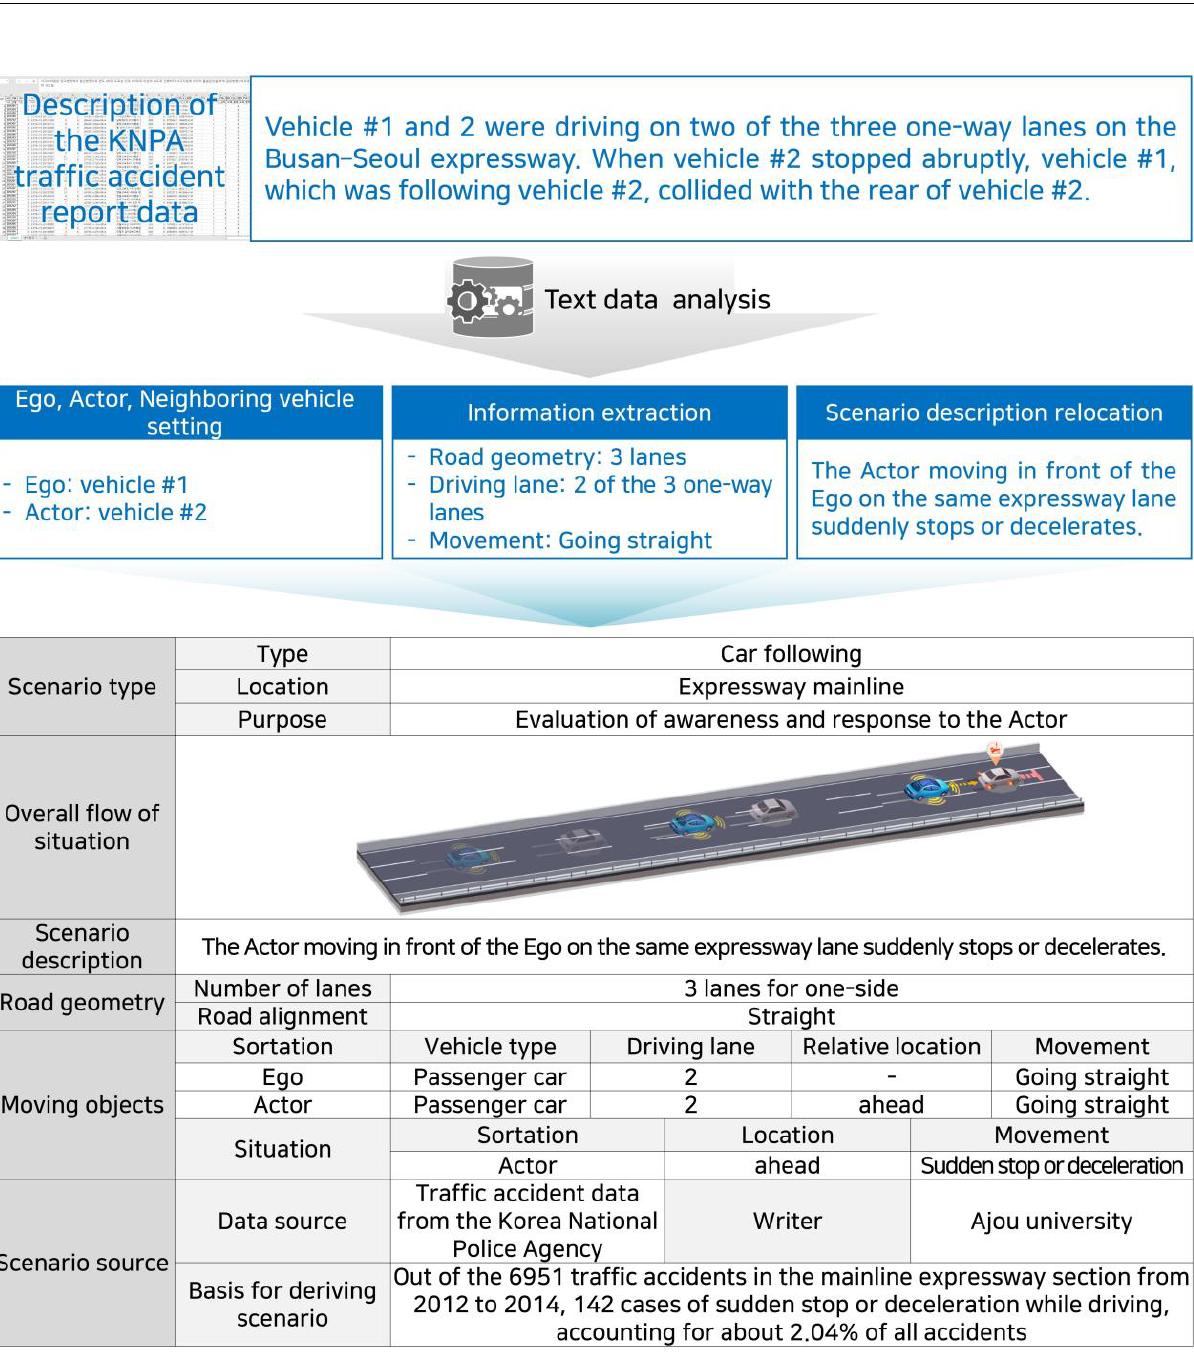
Figure 2. Functional scenario generation result.